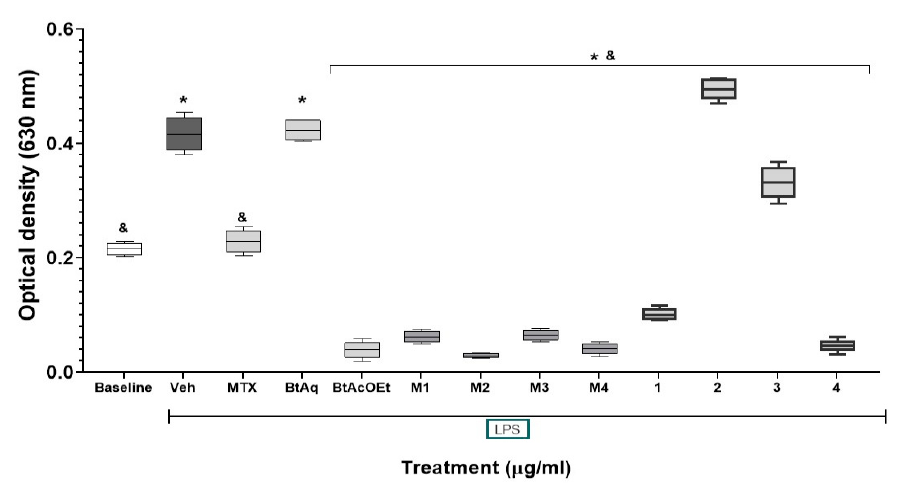
Figure 7. Inhibitory effect of the extracts, fractions, and compounds of B. ternifolia root on the expression of NF- κ B in Raw-Blue 264.7 macrophages. We applied an LPS stimulus in all treatments except for the basal expression group. The aqueous extract BtAq and the ethyl acetate extract BtAcOEt were derived from the bipartition of the complete extract. Fractions M1, M2, M3, and M4 were obtained from BtAcOEt. Ternifoliol ( 1 ), ternifolial, ( 2 ) bouvardin ( 3 ), and scopoletin ( 4 ) were isolated from previous fractions. ANOVA with post hoc Tukey test with & p < 0.05 compared with Veh group ( n = 6 ± SD). Comparison against negative control damage group (*).